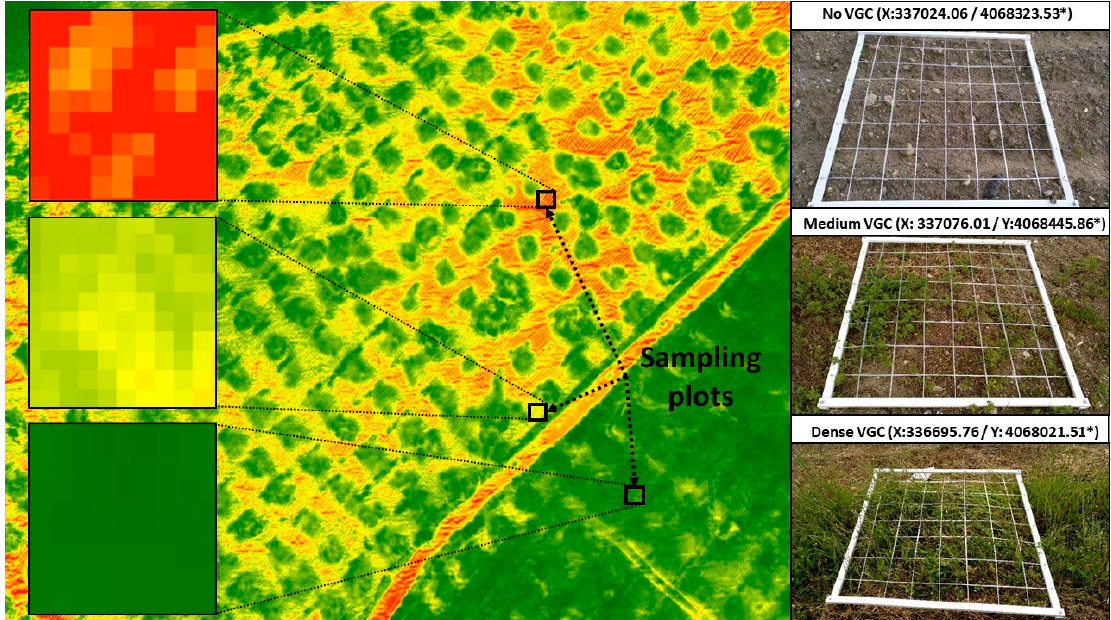
Figure 5. Random distribution of the sampling plots within the NDVI image (centre), detail of the pixels constituting the average NDVI reflectance value for each SP (left), ground-truth (right) (* Coordinate System: ETRS 1989 UTM Zone 30N).